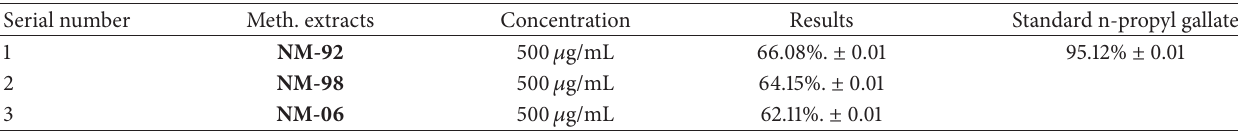
Table 3: Antioxidant activities of methanolic crude fraction of Vigna radiata NM-92, NM-98, and NM-06 against DPPH radical. Serial number Meth.